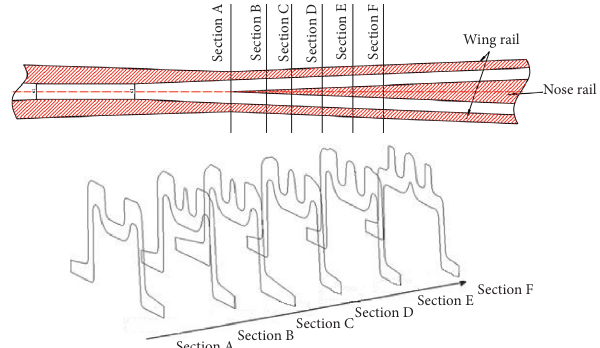
Figure 3: Cross sections of the fixed frog.